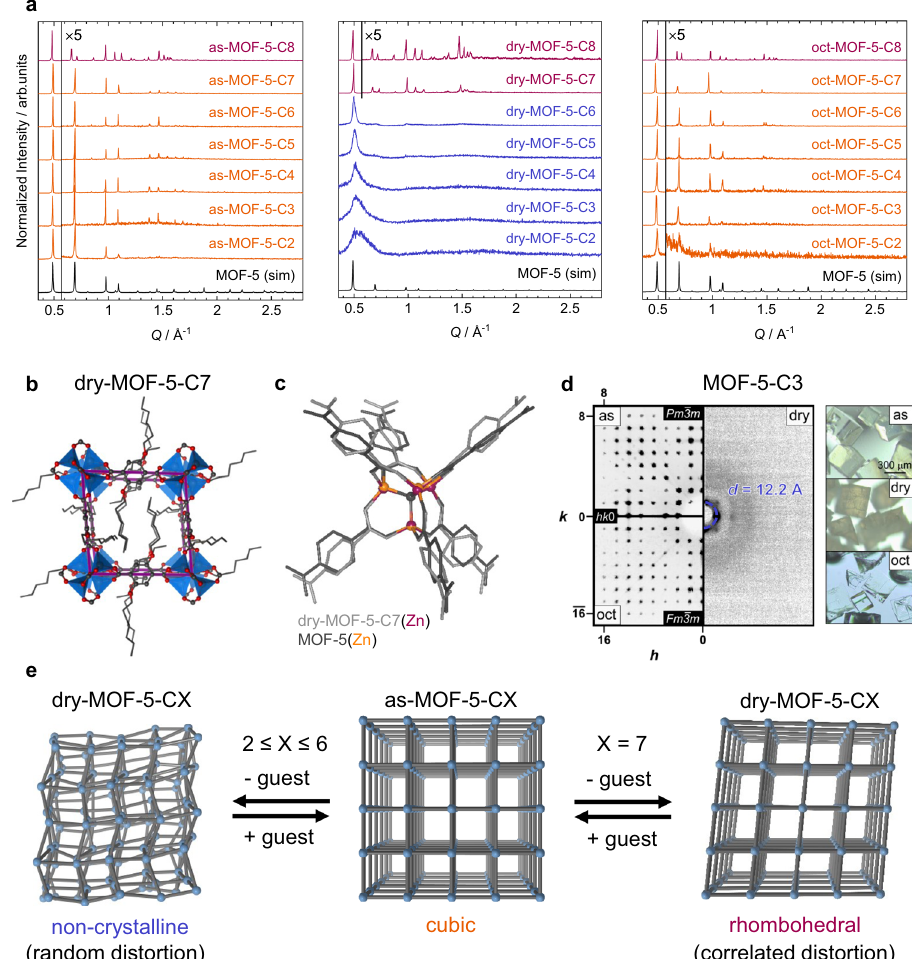
Fig. 2 Guest-responsive structural behaviour of MOF-5-CX. a PXRD data of the MOF-5-CX in their as (as-synthesized), dry and oct ( n -octane resolvated) states in comparison to the simulated diffraction pattern of MOF-5 (CCDC deposition code 256965). Cubic, rhombohedral and non-crystalline states are highlighted in orange, purple or blue colour, respectively. b Rietveld re fi ned crystal structure of rhombohedrally distorted dry-MOF-C7 (space group R (cid:1) 3, unit cell edges coloured in purple). c Overlay of the structures of regular MOF-5 (grey, zinc cations in orange) and dry-MOF-5-C7 (light grey, zinc cations in purple) with emphasis on the relative distortion of the [Zn 4 O(O 2 C) 6 ] building unit. d SCXRD data showing the loss and recovery of the (single-) crystalline order from as- to dry- to oct-MOF-5-C3 and microscopy images illustrating the visual impact of the structural transformations. e Graphical representation illustrating the guest-responsive structural behaviour of the MOF-5-CX